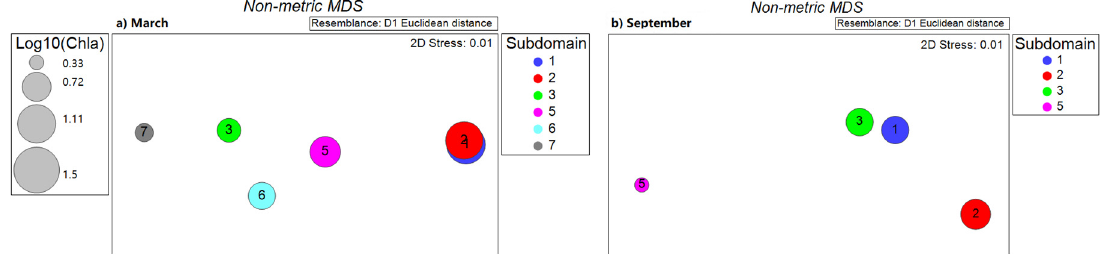
Figure 12. Spatial differences of Chl-a among subdomains according to the non-metric multidimensional scaling ordination (nMDS) analysis for (a) March and (b) September. Not enough Chl-a data were available to include Subdomain 4. Chl-a units in (mg m − 3 ). Table 2. Linear Pearson correlations between Chl-a and physical variables and nutrient content in each subdomain and for both periods (March and September).